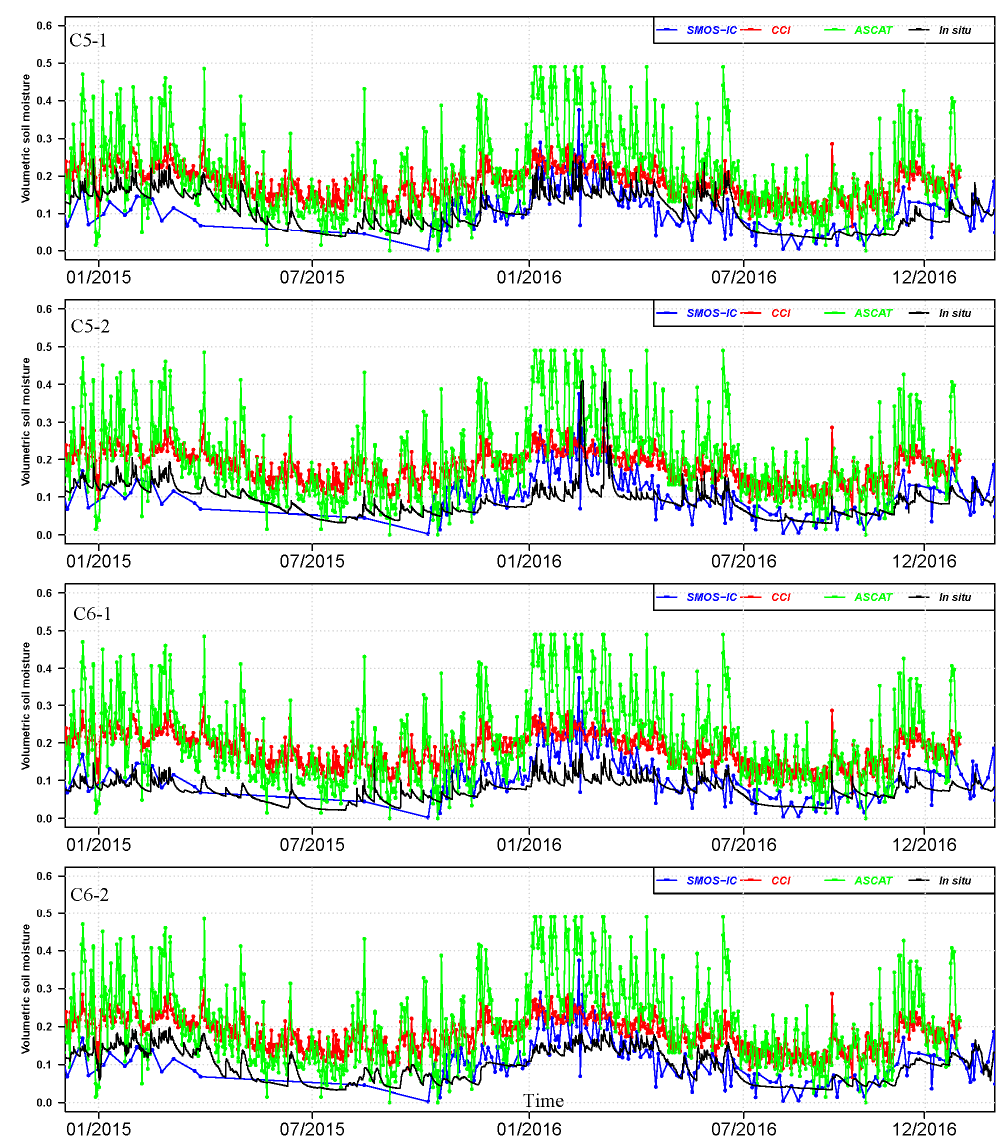
Figure 6 . Same as Figure 4 but with the Hermitage in situ soil moisture observations. Figure 6. Same as Figure 4 but with the Hermitage in situ soil moisture